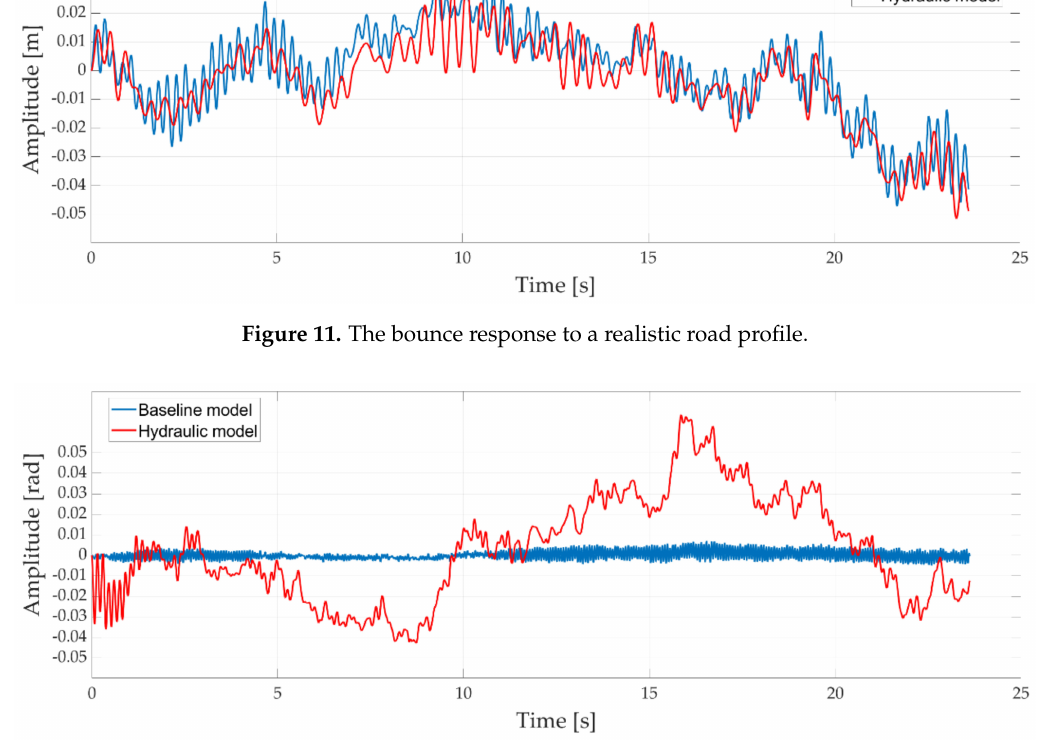
Figure 12. The roll response to a realistic road profile.